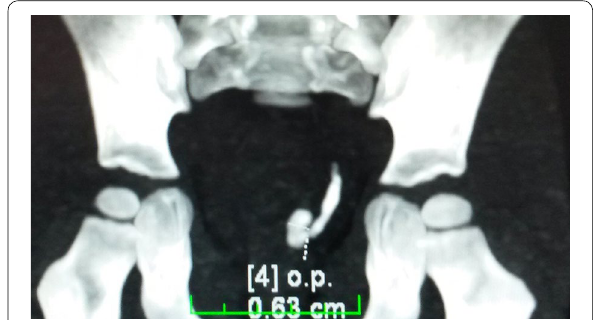
Fig. 1 One stone image in left ureter in CT